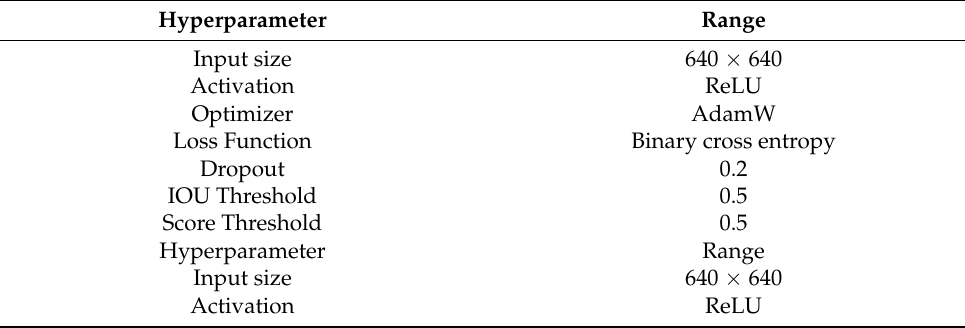
Table 1. Main hyperparameters used for SegDetector training and testing.